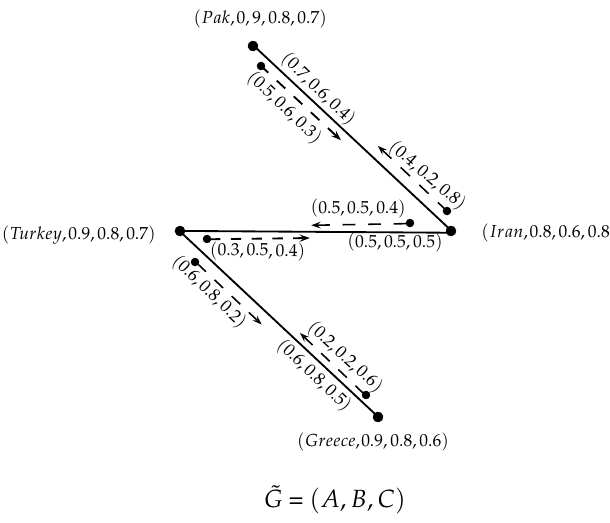
Figure 8. Model of the situation of illegal migration from Pakistan to Europe.